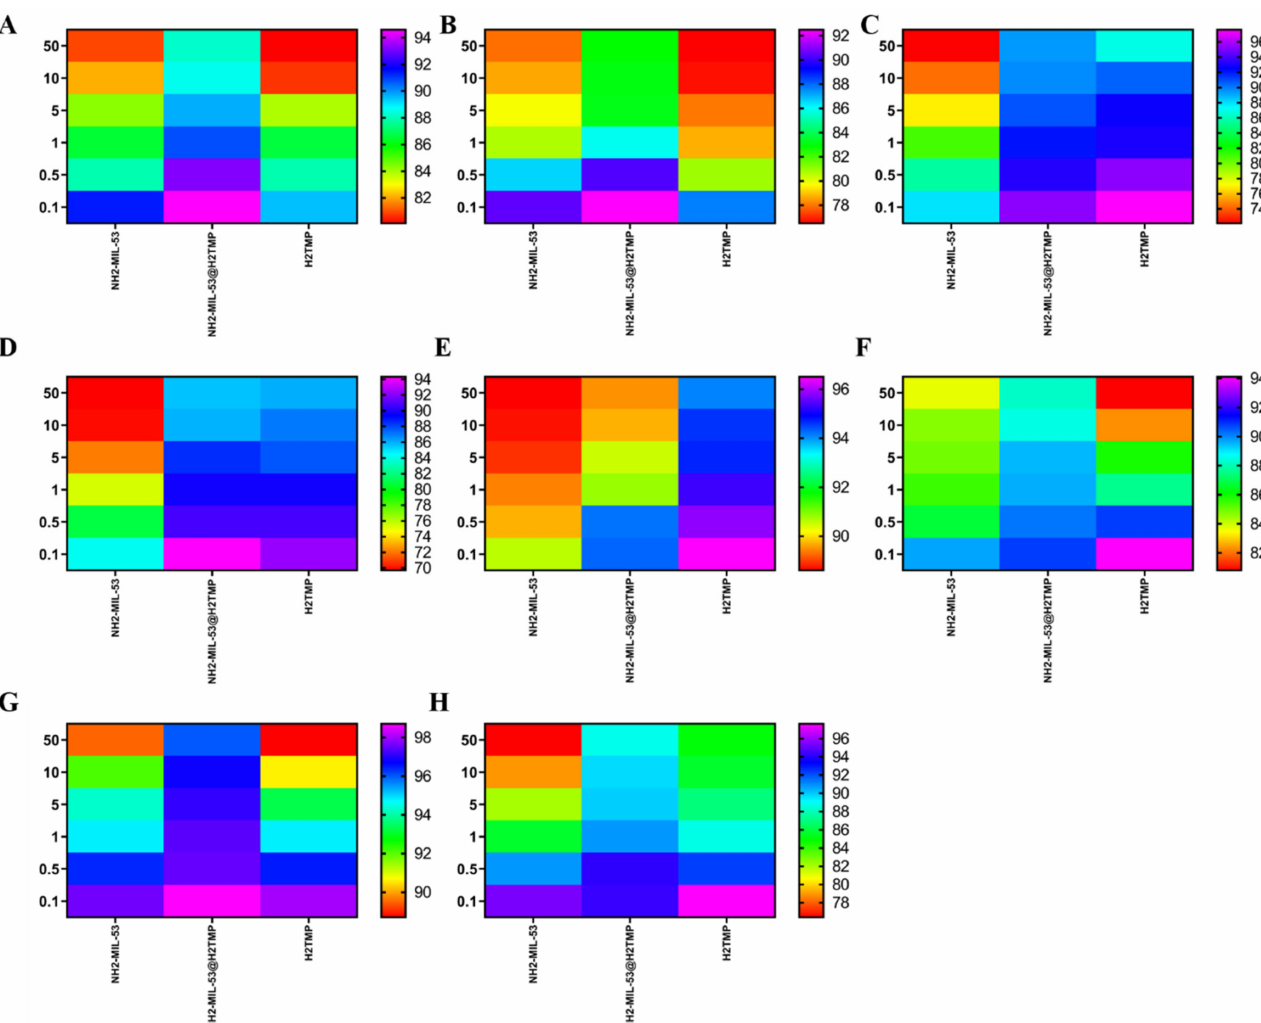
Figure 6. MTT results (dose-dependent with the heat-map shape) of the synthesized nanomaterials on the HEK-293 ( A , B ), HeLa ( C , D ), HepG2 ( E , F ), and PC12 ( G , H ) after (24 and 48) hours of treatment, respectively. Also, in order to determine the possible interactions with the cell membranes and its relationship with the destructive/negative effects on the in vitro cellular experiments, the NH 2 -MIL-53@H 2 TMP was exposed to MCF-7 cell line (stained with 4 (cid:48) ,6-diamidino-2- phenylindole (DAPI)) for 48 h, and the morphology of the cells was investigated by confocal laser scanning microscopy (CLSM). The results showed that (Figure 7) the synthesized- decorated MOF does not have any significant cytotoxicity to the cancerous cell line; there- fore, the morphology of the stained cells did not